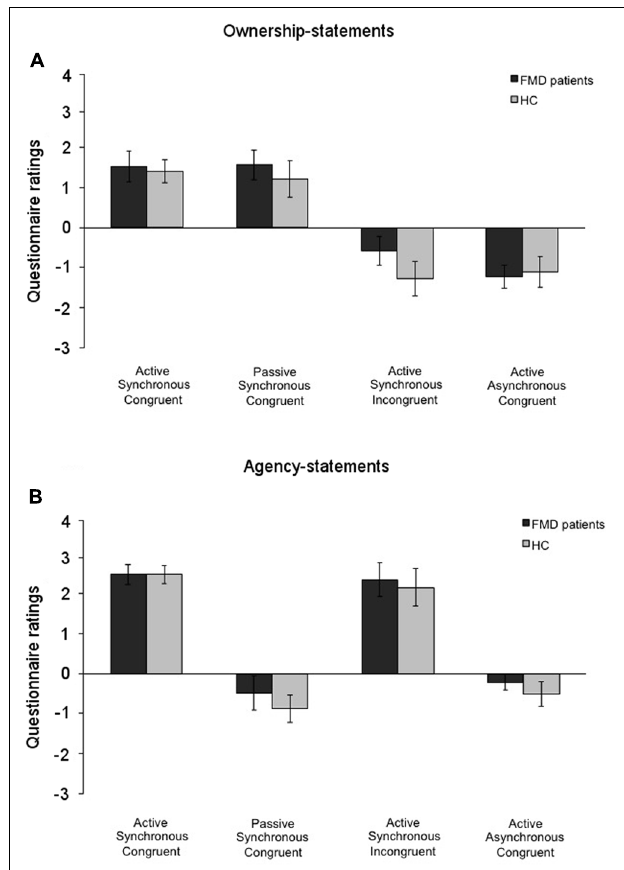
FIGURE 5 | Ownership and agency for all the conditions in the functional movement disorders and the healthy controls groups. Mean scores for the (A) ownership-statements and (B) the agency-statements in the functional movement disorders group (FMD; black columns) and the healthy controls group (HC; gray columns). The two groups showed similar patterns of response. Error bars represent standard